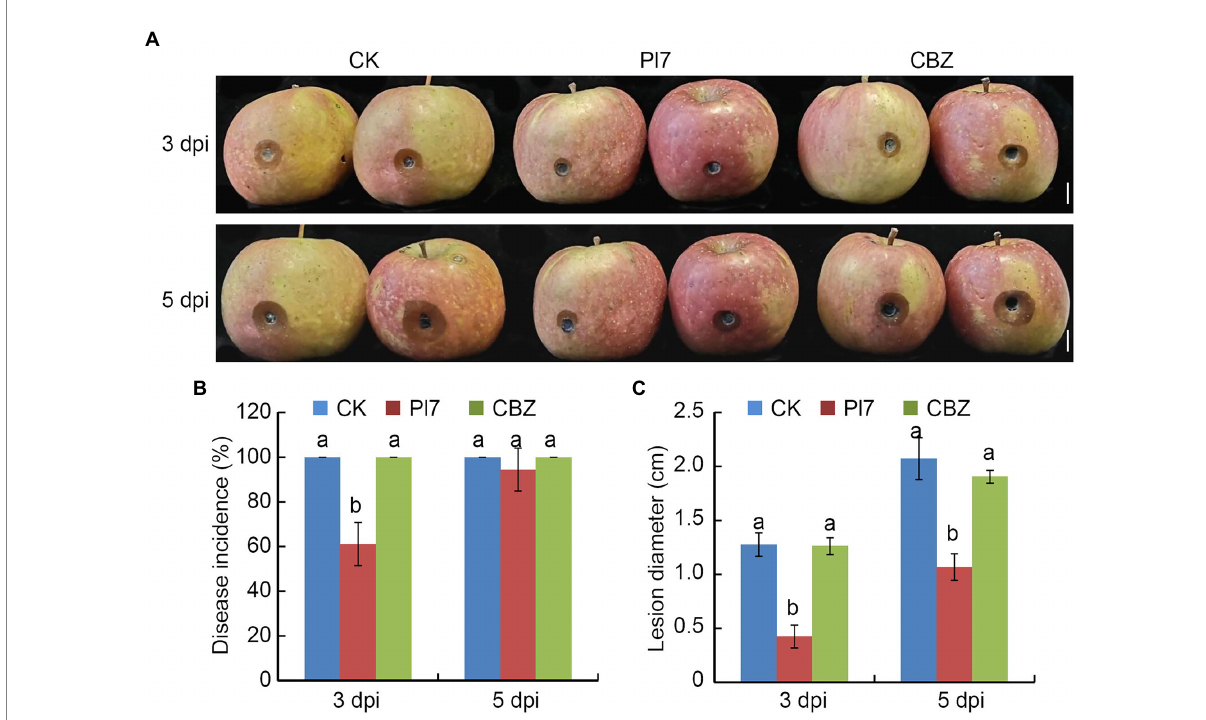
FIGURE 8 Antifungal activity of B. halotolerans strain Pl7 prevents CBZ-resistant isolate-caused apple ring rot. (A) Controlling apple ring rot by strain Pl7 cell suspension. Bar, 1 cm. (B) Disease incidence. Data are presented as the mean ± SD of three independent replicates. (C) Disease lesion size. Data are presented as the mean ± SD of three biological replicates. Different lowercase letters represent significantly different means at p < 0.05 (Duncan’s multiple test). This experiment was performed independently three times with similar